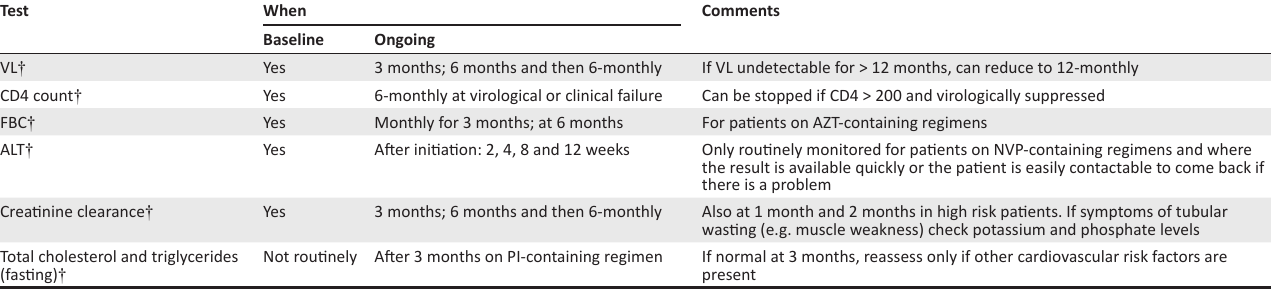
TABLE 5: Standard laboratory monitoring of patients once commenced on antiretroviral therapy. Test